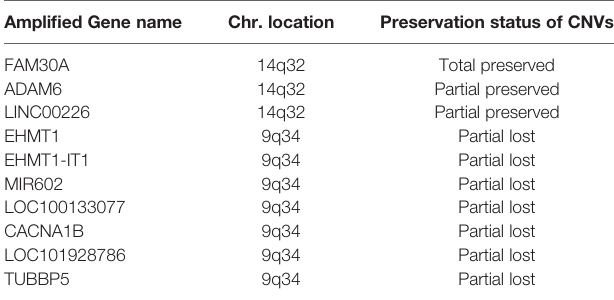
TABLE 3 | Preservation and lost of genes with CNA gain in patient-derived primary cells compared to their original tumors in the grade II/III